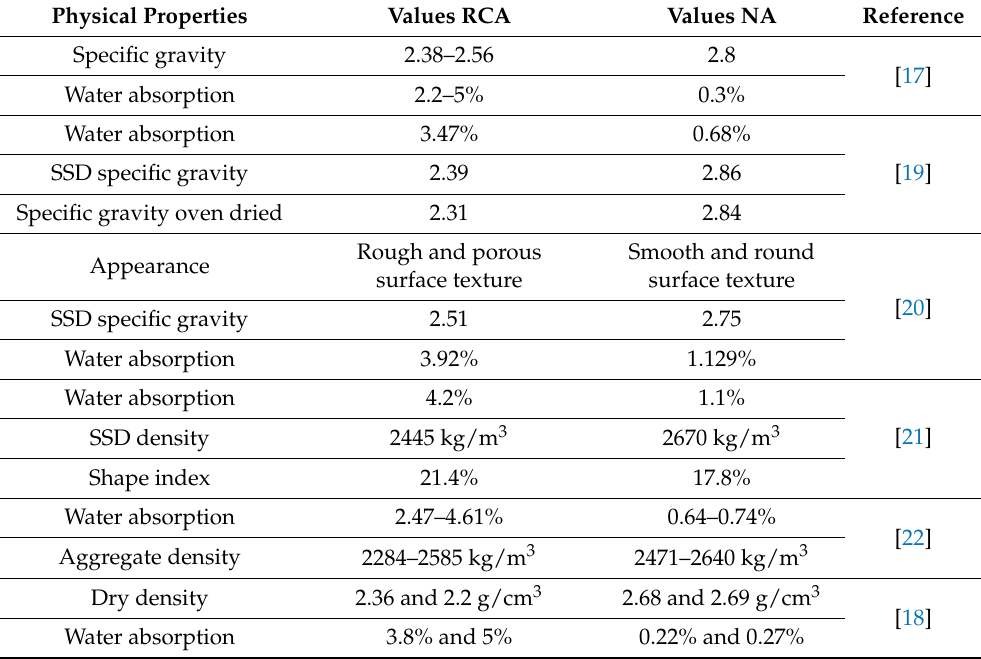
Table 1. Comparison of physical properties between RCA and